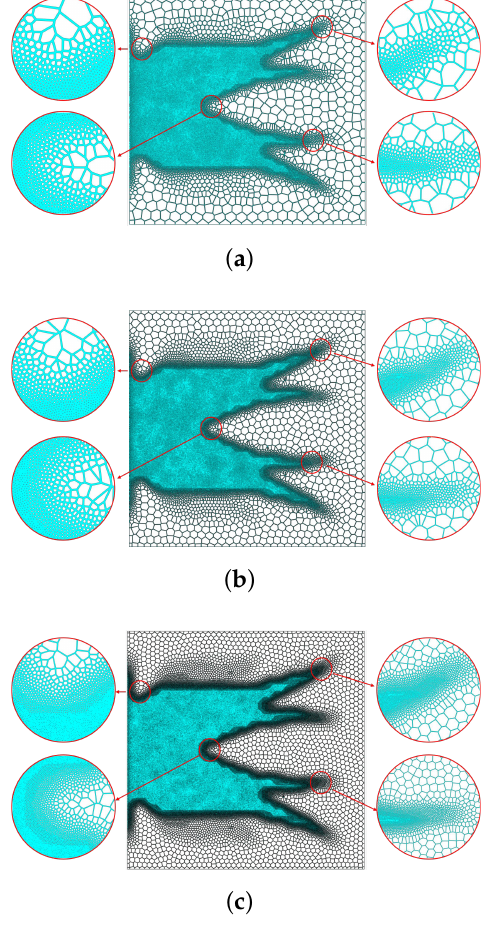
Figure 8. Size effect analysis: ( a ) the Voronoi-GSCS obtained with a strut width of t = 0.08; ( b ) the Voronoi-GSCS obtained with a strut width of t = 0.06; ( c ) the Voronoi-GSCS obtained with a strut width of t =